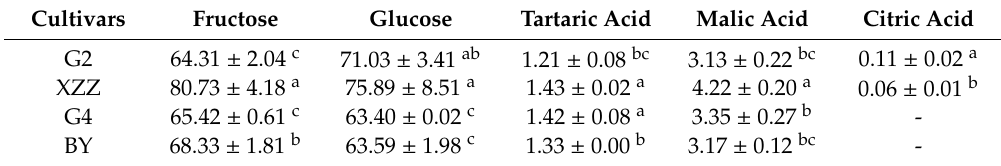
Table 1. Soluble sugar and organic acid composition of Chinese wild spine grapes (g /